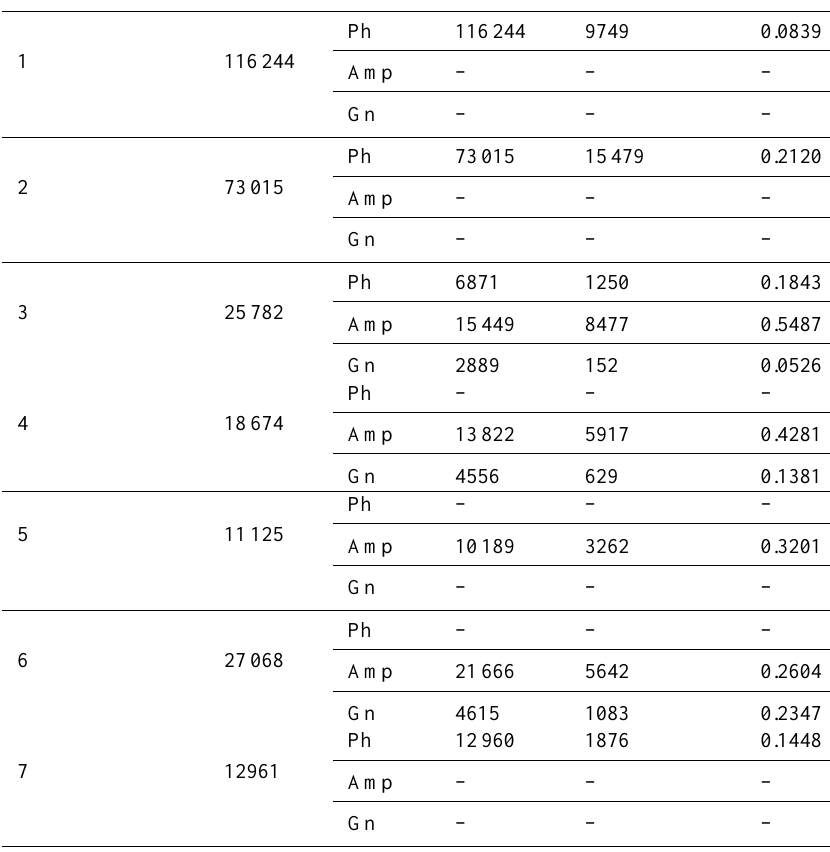
Table 2. Parameters involved in the calculation of the DSI index. Ph=Phillites and metasandstones of Mandanici Unit; Amp=Amphibolites of the Aspromonte Unit and Gn=Gneiss of Aspromonte